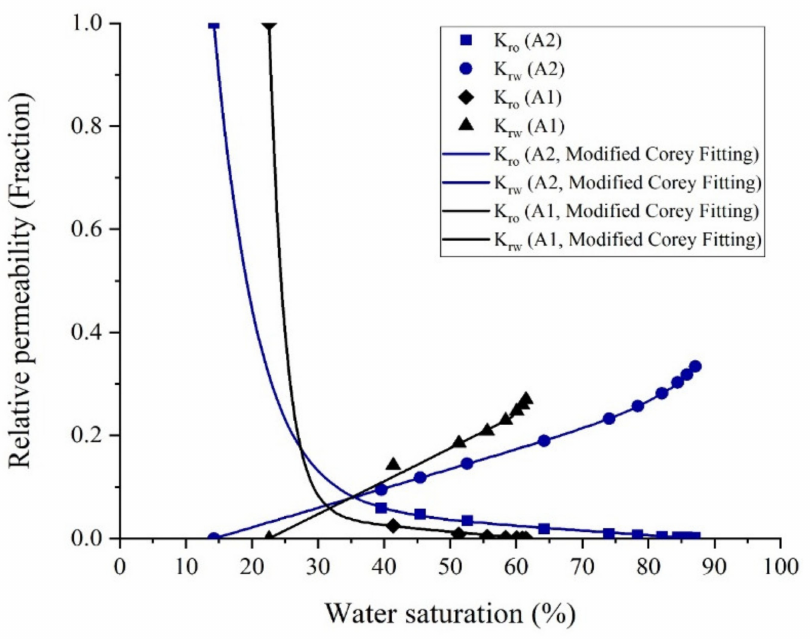
Figure 19. Relative permeability curve for cores A1 and